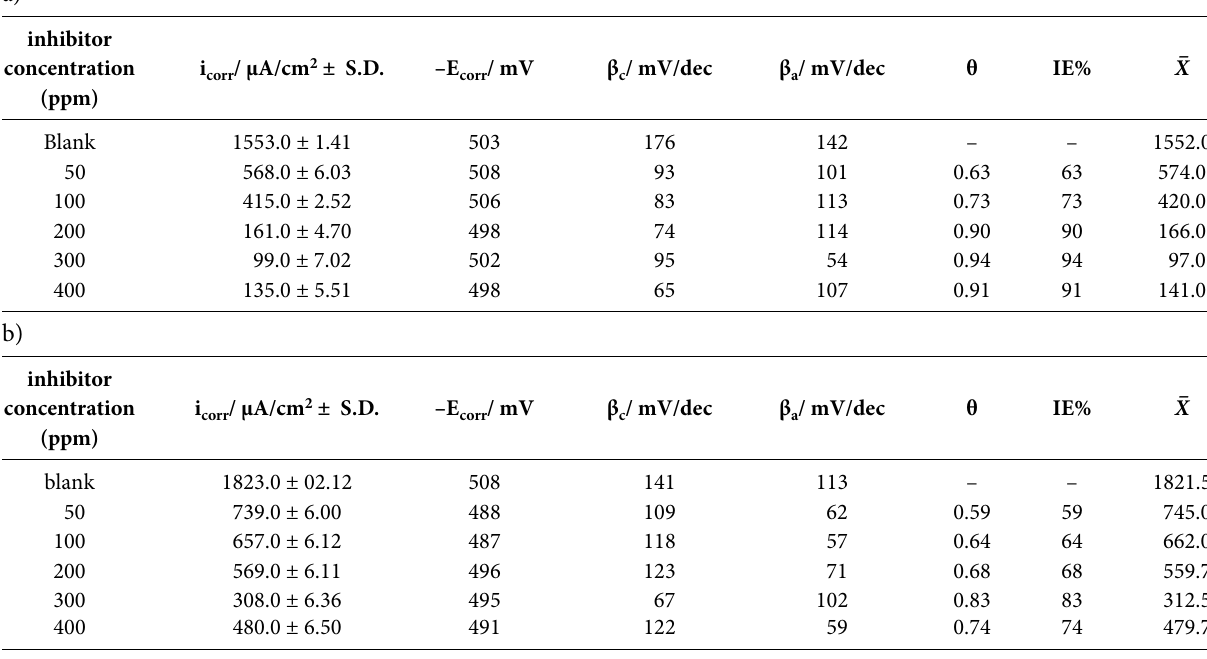
Table 2. Corrosion parameters derived from polarization curves for mild steel in a) hydrochloric acid and b) sulfuric acid solution in absence and presence of different concentrations of inhibitor at 25 ± 1 °C. (Results derived from at least two repeats of experiment.)